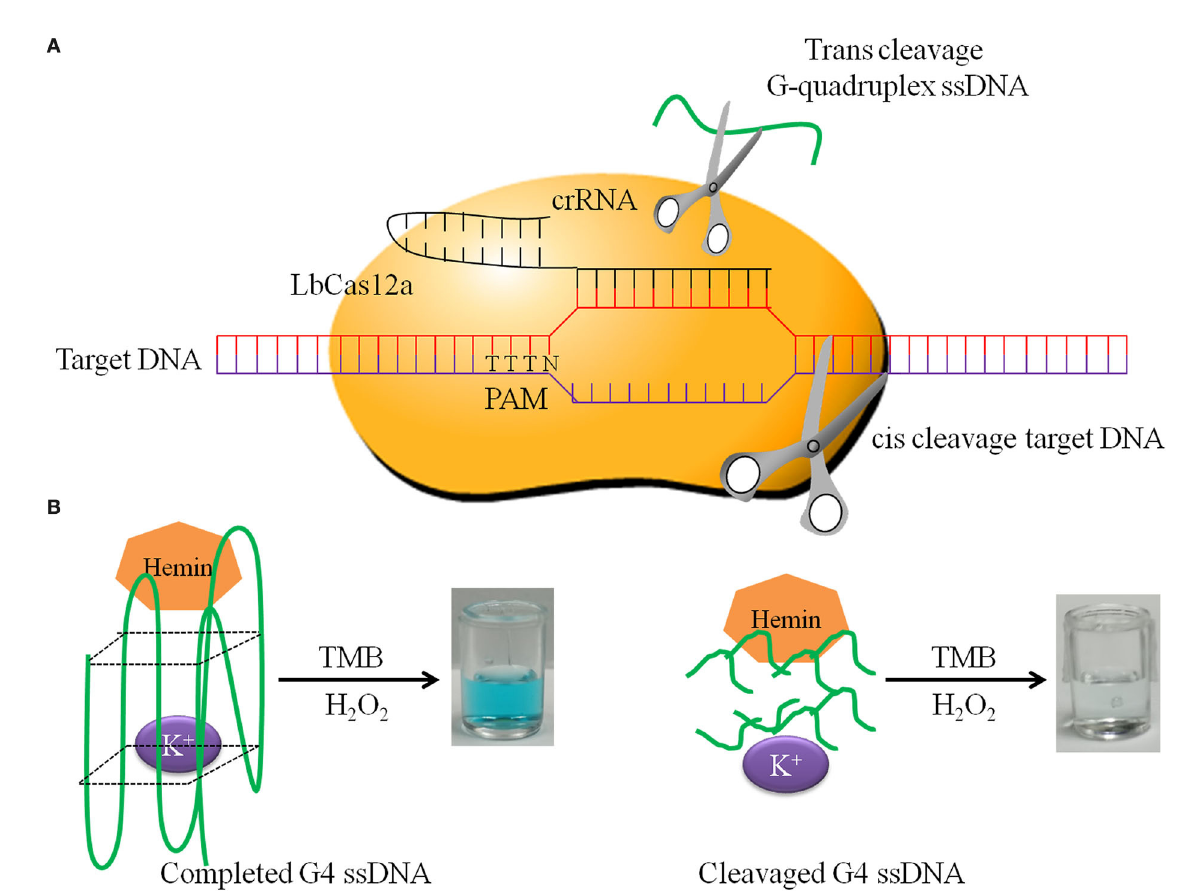
FIGURE1 The principle of DNA detection by CRISPR-Cas12a. (A) LbCas12a cis-cleavage target DNA and trans-cleavage non-specific G-quadruplex ssDNA. (B) Completed G-quadruplex ssDNA has HRP activity in the presence of K + and hemin, which has the ability to catalyze TMB and H 2 O 2 to form green products. In contrast, cleavaged G-quadruplex ssDNA does not have this